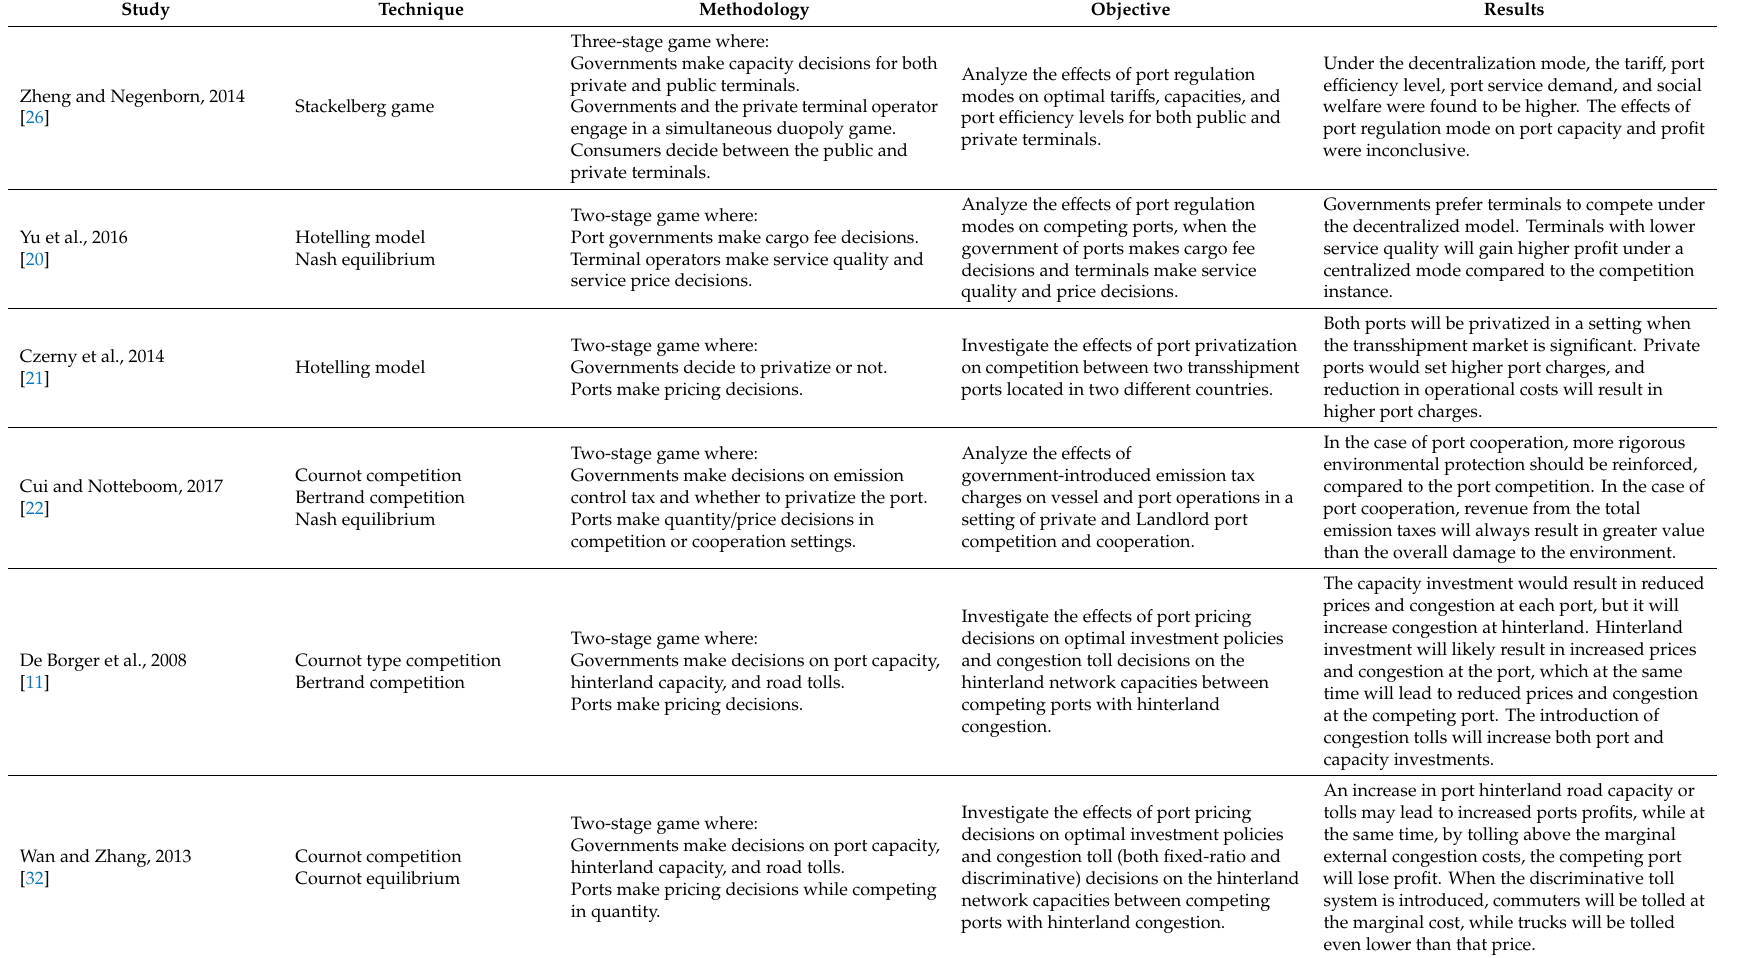
Table 3. Summary of Government and Container Terminal